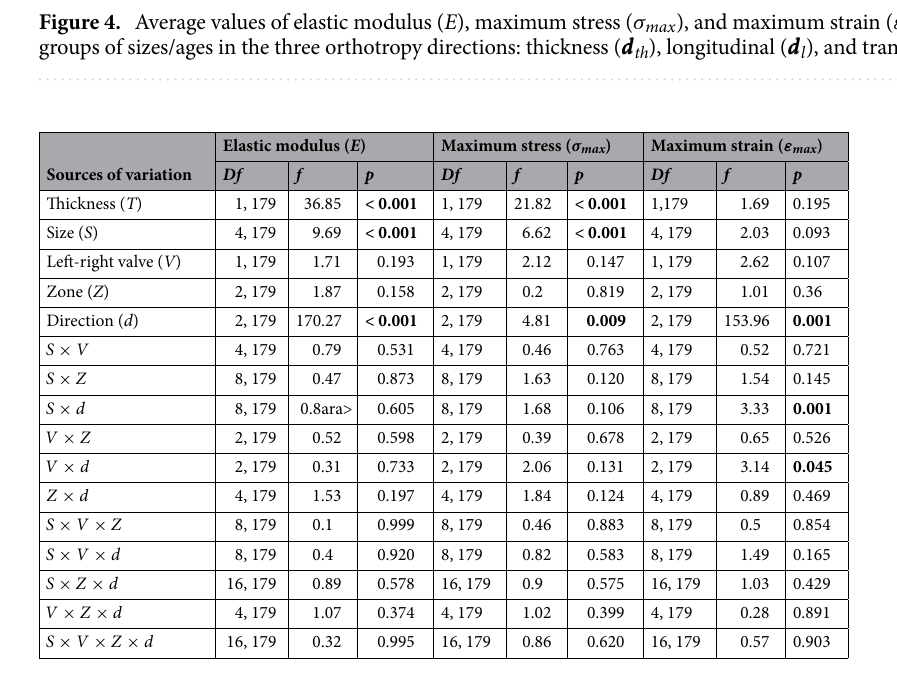
Table 2. Results of ANCOVA analysis for elastic modulus ( E ), maximum stress ( σ max ), and maximum strain ( ε max ). The shell thickness ( T ) mm of each individual was used as a covariate. Five size ranges ( S ), the left and right valves ( V ), the three shell zones ( Z ), and three compression directions ( d ) were considered. Df , degrees of freedom; f , f-statistic; p , p-value . Significant p values ( < 0.05 ) are shown in